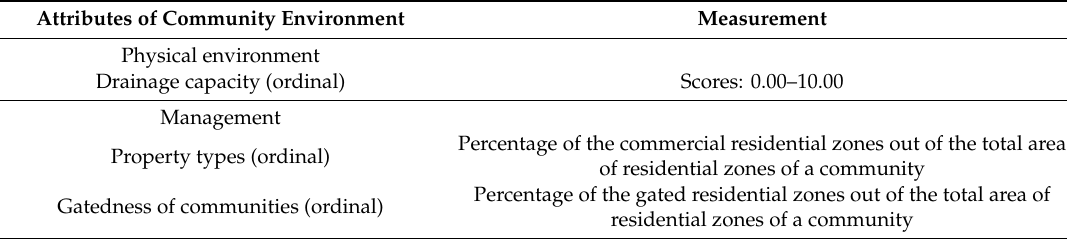
Table 2. Measurements of independent variables (community level).